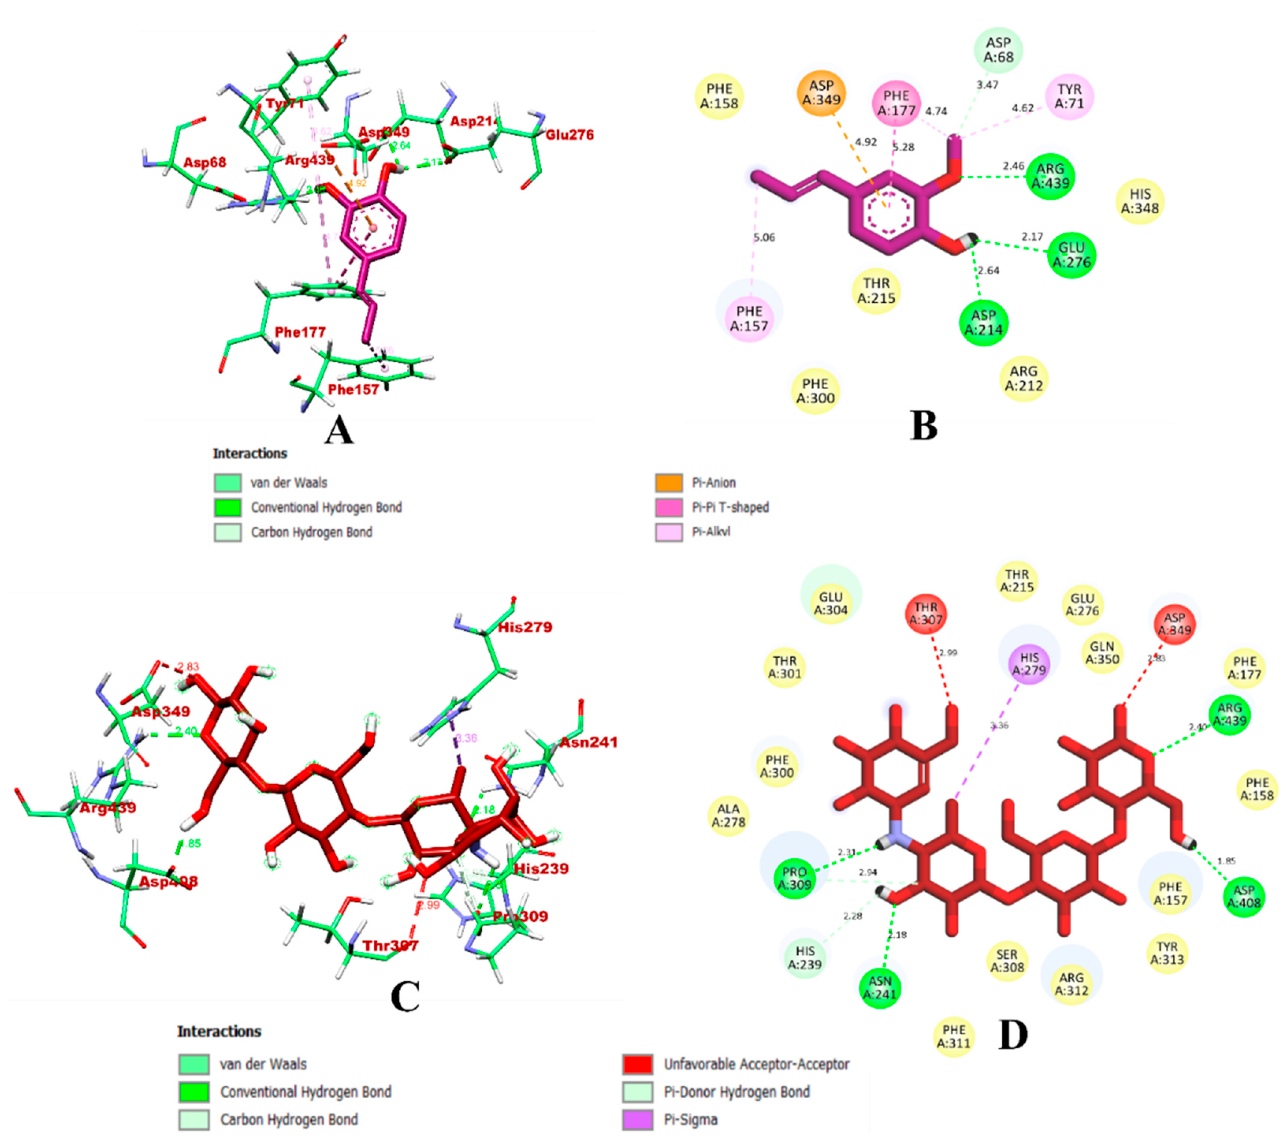
Figure 1. Visualization of the docking simulation of the compounds with α -glucosidase. ( A , B ) Interaction of isoeugenol (purple) visualized in 3D and 2D, respectively. ( C , D ) Interaction of acarbose (red) visualized in 3D and 2D, respectively.